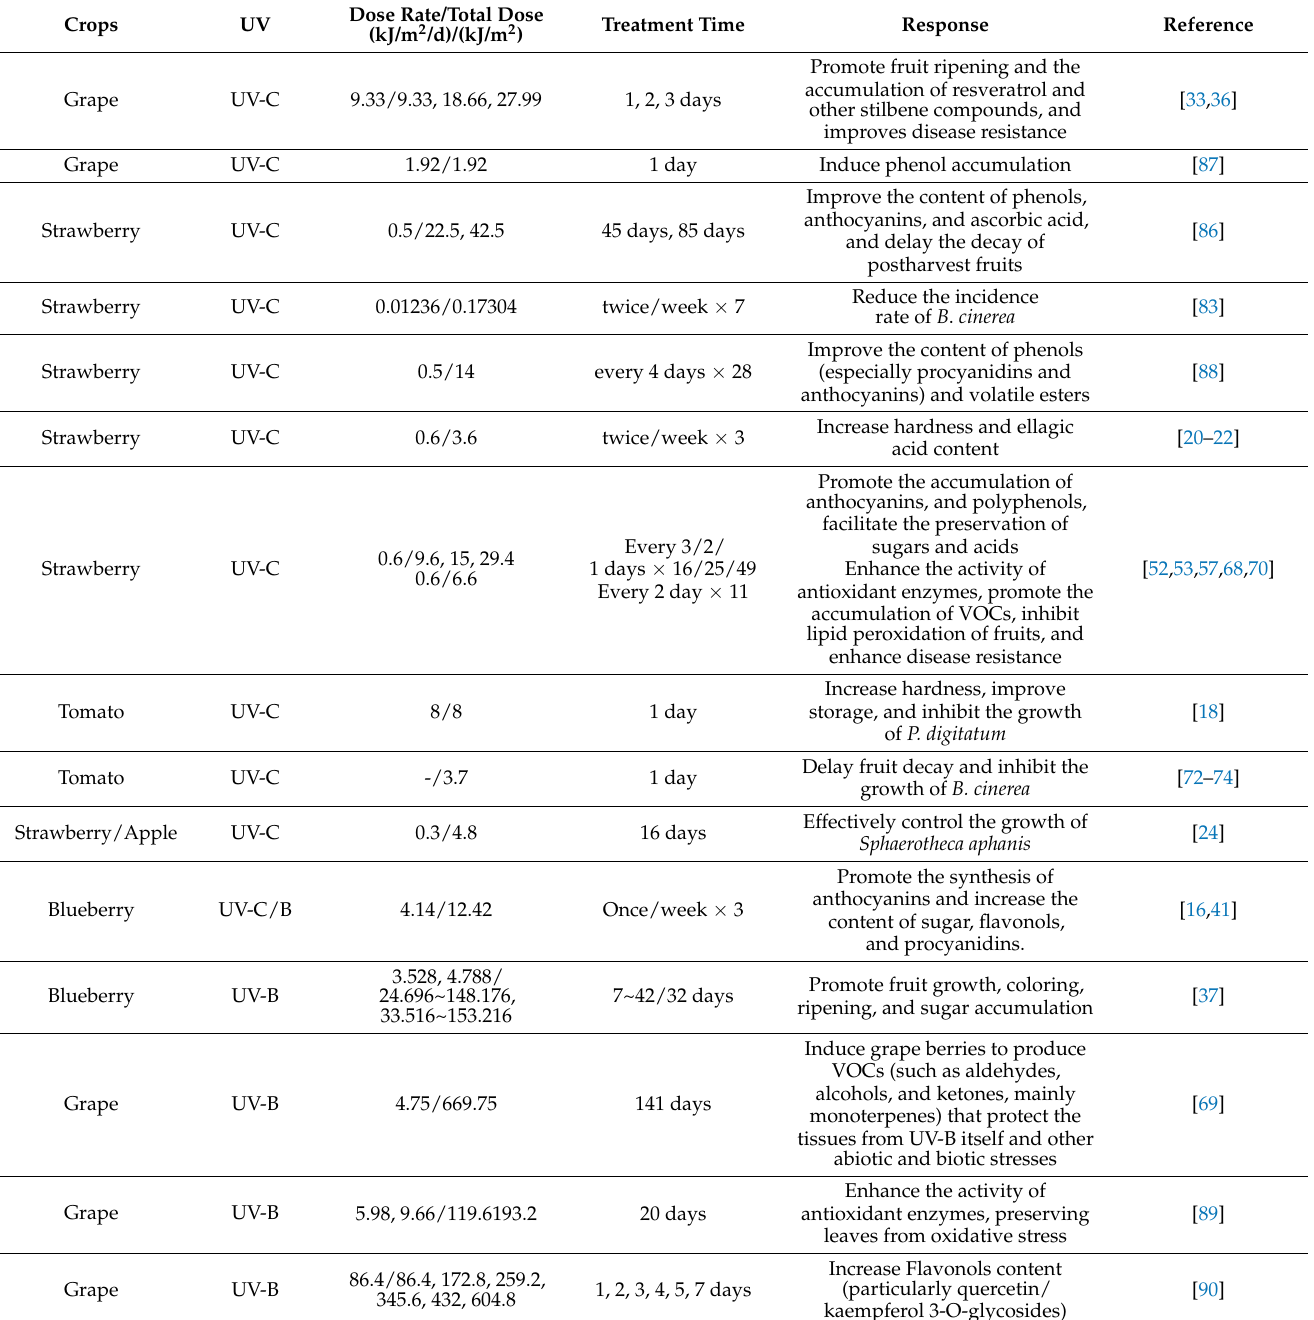
Table 1. Application of preharvest UV irradiation in berry